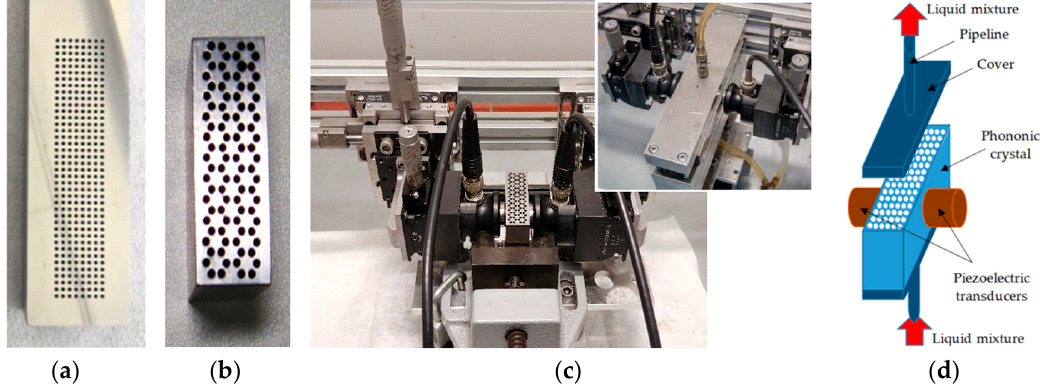
Figure 3. The steel plate with cubic ( a ) and honeycomb ( b ) periodic arrangement of cylindrical holes; ( c ) experimental setup; ( d ) schematic representation of the experimental setup.